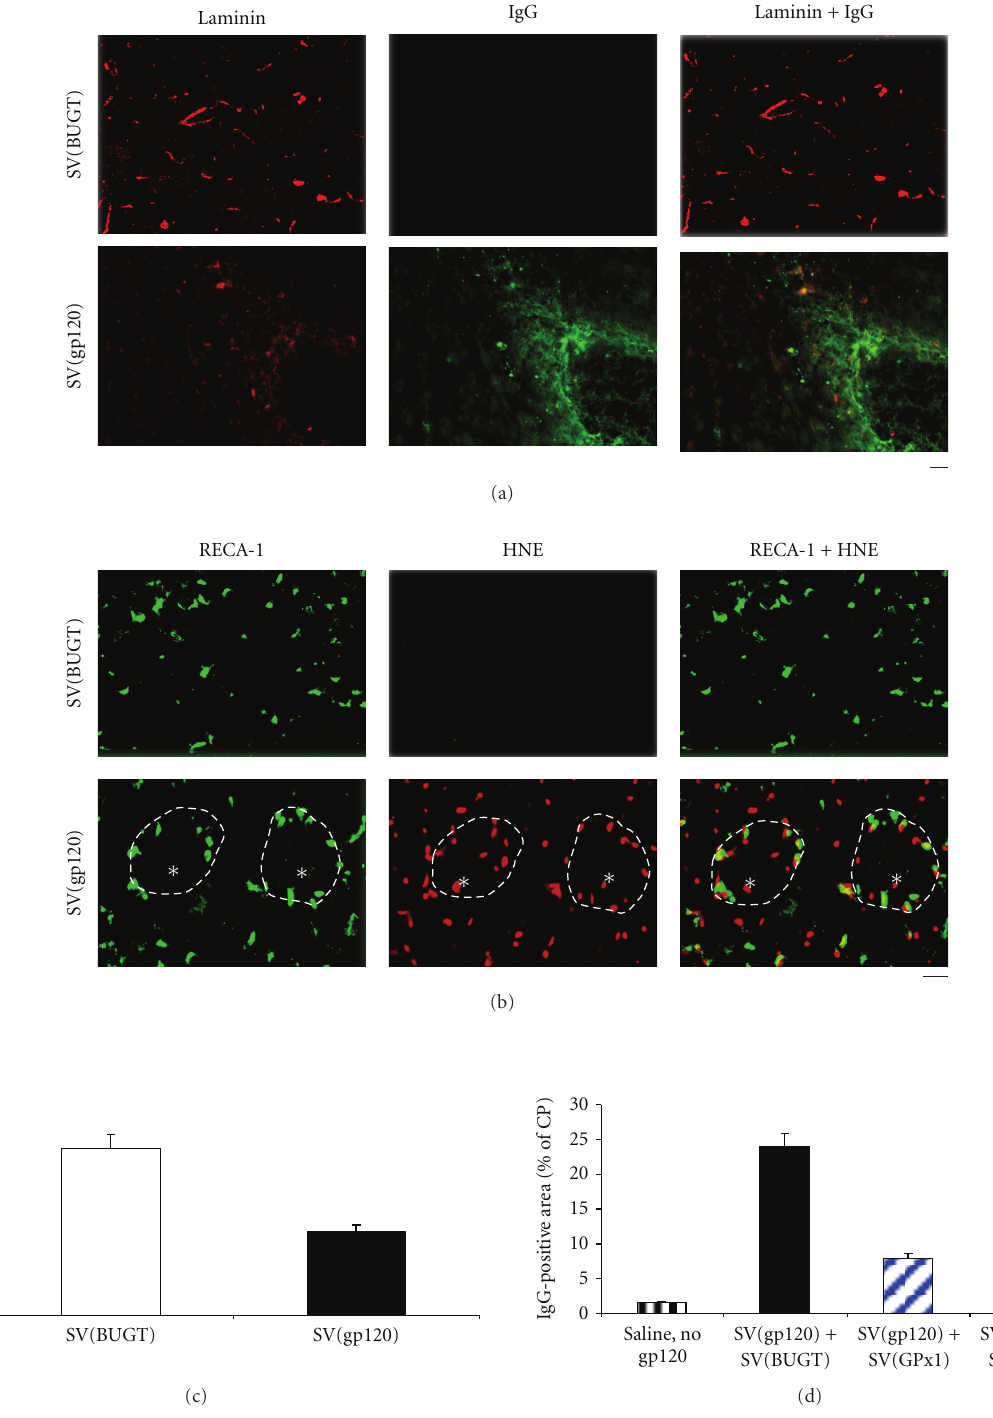
Figure 8: Injection of SV(gp120) into the CP increased BBB permeability. (a) Cryostat sections of the CP from rats injected with SV(gp120) or a control vector, SV(BUGT), at the level of the striatum, were immunostained for IgG (to evaluate leakage of plasma protein through the BBB) and laminin. Seven days after injection of SV(gp120) into the CP, significantly less laminin-positive structures were seen, particularly in the areas of IgG accumulation, while laminin immunostaining was normal and no IgG leakage was observed after injection of SV(BUGT). (b) Sections of rat CPs injected with SV(gp120) or a control vector, SV(BUGT), were immunostained for HNE, a marker of lipid peroxidation, and RECA-1, a marker of endothelial cells. Immunostaining for HNE was seen in the CPs injected with SV(gp120) and colocalized with RECA-1, while no HNE immunoreactivity was detected in CPs injected with SV(BUGT). (c) Injection of SV(gp120) induced a decrease in the number of laminin-positive structures. (d) Prior gene delivery of antioxidant enzymes into the CP before injection of SV(gp120) decreased the extent of IgG-positive area after intra-CP injection of SV(gp120). Bar: (a) 60 μ m; (b) 50 μ